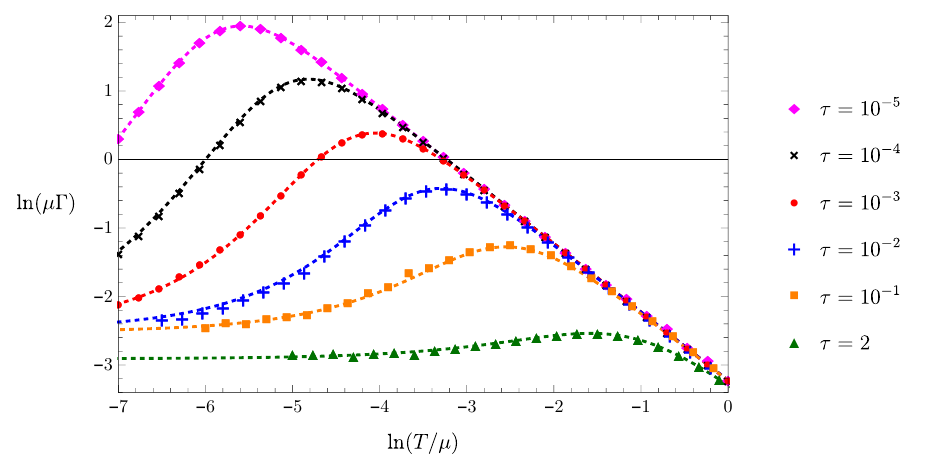
Figure 20. Our numerical results for ln ( (cid:22) (cid:0)) versus ln ( T=(cid:22) ) for ~ (cid:11) = 1, k=(cid:22) = 10 (cid:0) 2 , and (cid:28) = 10 (cid:0) 5 (pink diamonds), 10 (cid:0) 4 (black crosses), 10 (cid:0) 3 (red dots), 10 (cid:0) 2 (blue plus signs), 10 (cid:0) 1 (orange squares), and 2 (green triangles). We obtain (cid:0) by numerically (cid:12)tting (cid:0) (cid:0) k 2 + (cid:14)k 4 to the sound pole’s Im ( ! ) over a range of small k=(cid:22) . The dashed lines show the corresponding results using the hydrodynamic form of eq. (3.3) with d = 3, namely (cid:0) = 1 agree with the hydrodynamic form for all (cid:28) and T=(cid:22)